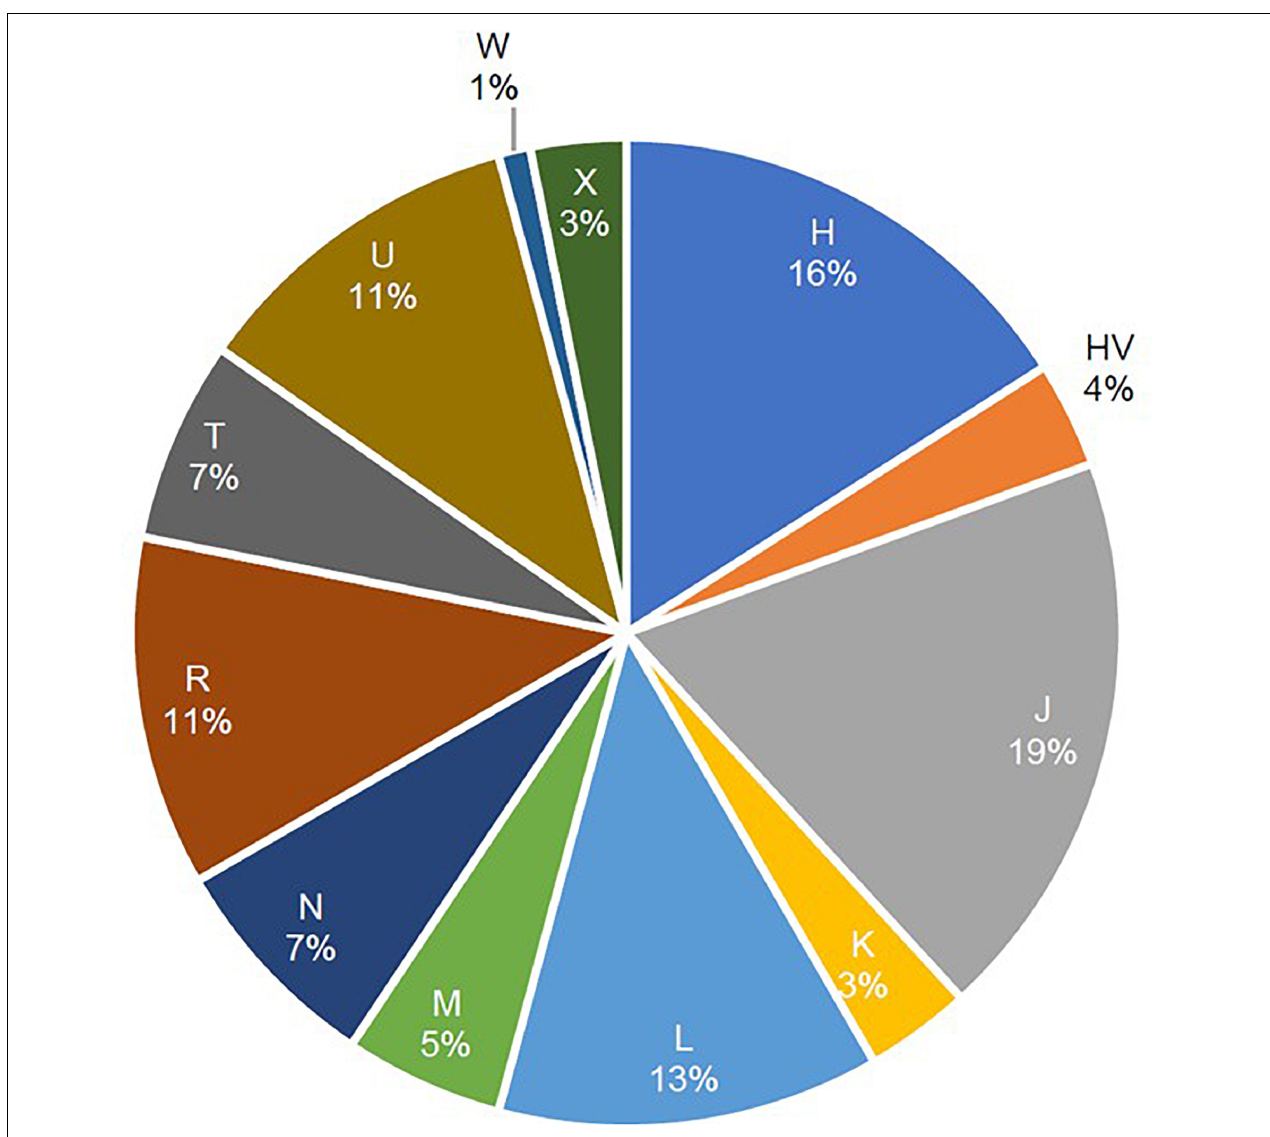
FIGURE 1 | Frequencies of mitochondrial haplogroups in the study cohort of 288 Arab individuals from